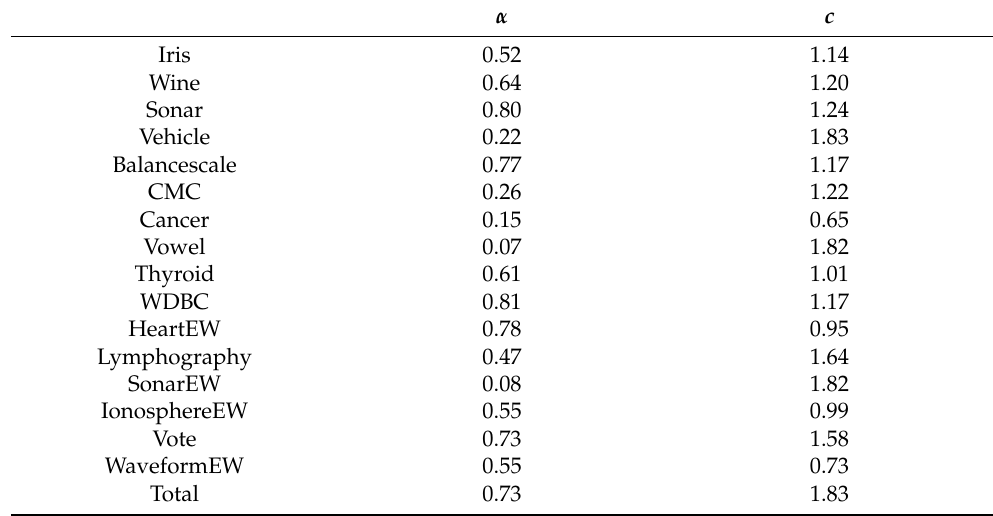
Table 5. The parameter obtained by